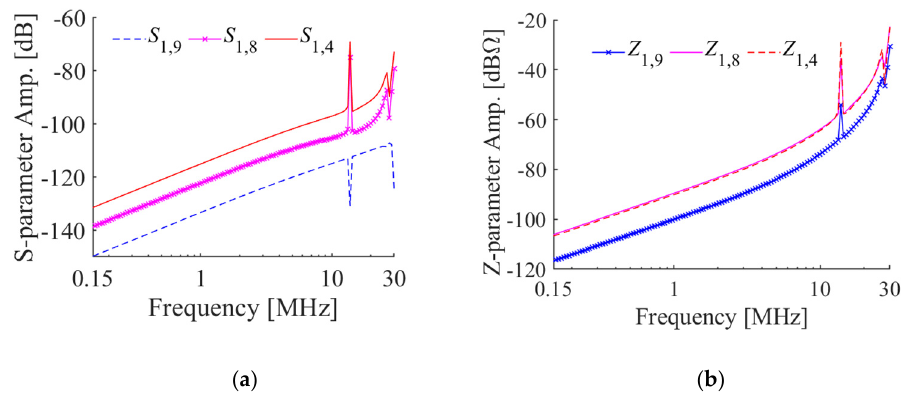
Figure 9. Parameters of networks: ( a ) S-parameter; ( b ) Z-parameter.